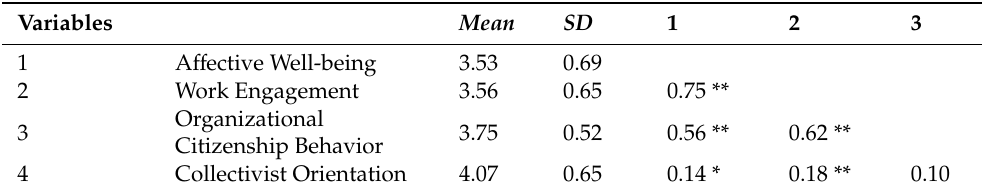
Table 2. Means, Standard Deviations, and Correlations for Relevant Variables.